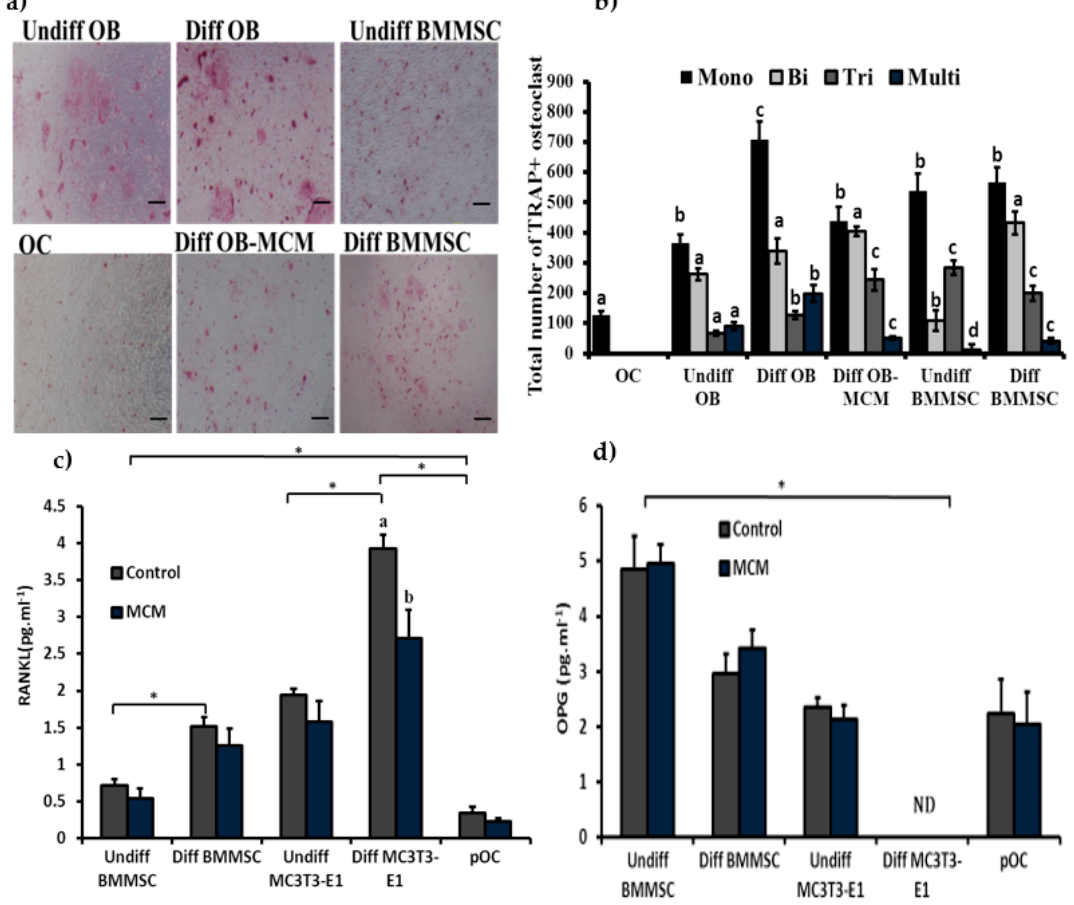
Figure 10. Different stages of osteogenic cells in osteoclast formation. Primary osteocytes and undifferentiated- and differentiated-bone cells (mesenchymal stem cells and osteoblasts) were co-cultured for 10 days with osteoclast precursor cells isolated from the femur and tibia of wild mice bone marrow. ( a ) Images of TRAP-stained osteoclasts; scale bars: 200 µm. ( b ) Total number (mono-, bi-, tri-, and multi-nucleated) of osteoclasts formed after co-culture; different letters indicate statistical significance between treatments. ( c ) The level of RANKL expression produced from different bone cells; different letters indicate statistical significance between control and MCM. ( d ) The level of osteoprotegerin (OPG) expression produced from different bone cells. Undiff OB: undifferentiated osteoblast, Diff OB: differentiated osteoblast, Undiff BMMSC: undifferentiated bone marrow mesenchymal stem cell, Diff BMMSC: differentiated bone marrow mesenchymal stem cell, OC: primary osteocytes, MCM: matrix conditioned medium. * p < 0.05 ( n = 3).